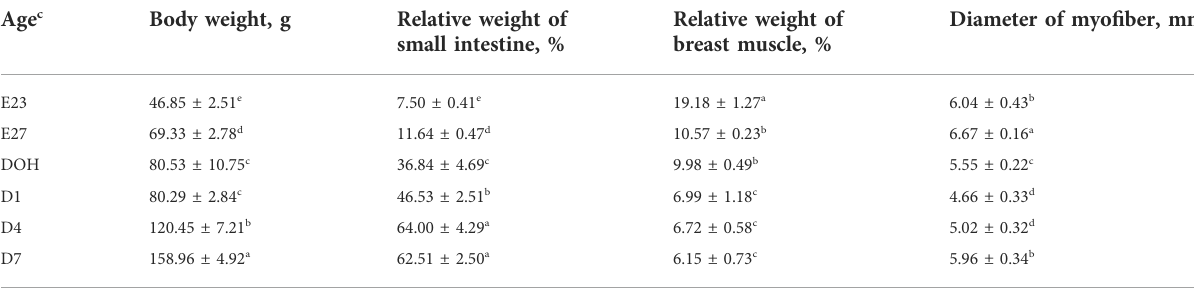
TABLE 3 Body weight, small intestine, and breast muscle parameters of goslings between embryonic day 23 to day 7 post hatching a,b